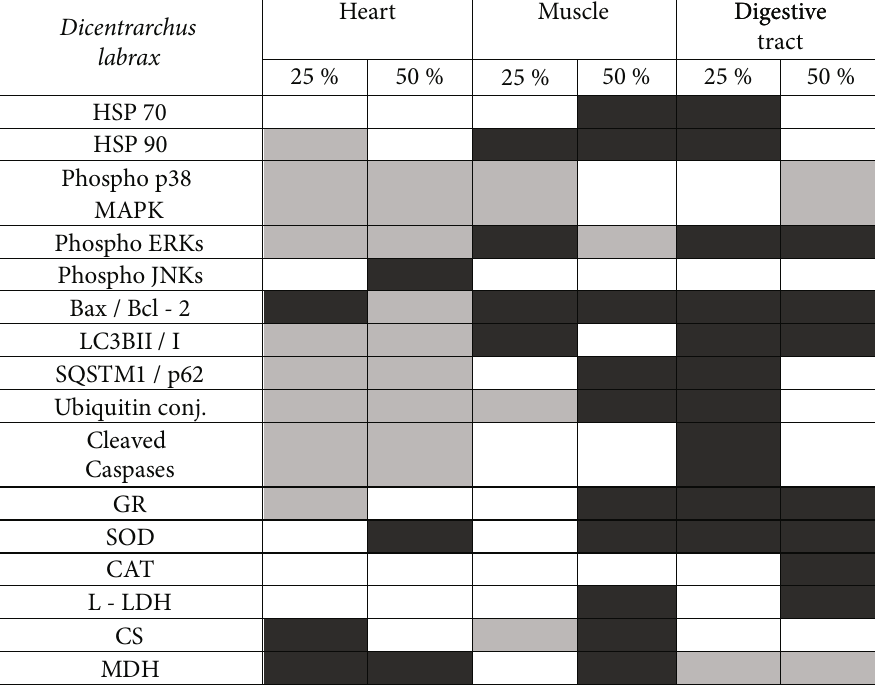
Figure 10: E ff ect of partial substitution (25 and 50%) of fi sh meal with insect meal (IM) on the four examined tissues (heart, liver, muscle, and digestive tract) of the sea bass ( Dicentrarchus labrax ). Dark grey indicates increase, light grey indicates decrease, and white indicates no change compared to the fi sh meal – control (0%